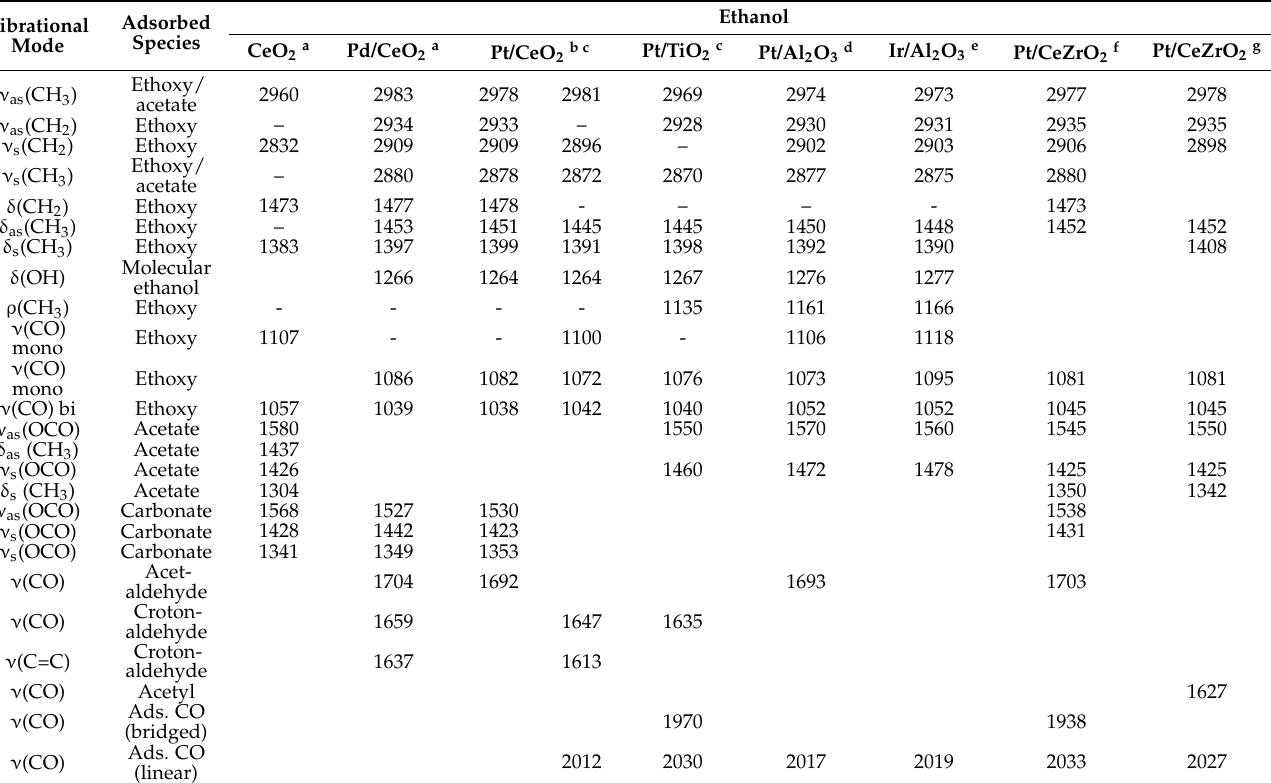
Table 2. IR vibrational wavenumbers in cm − 1 and mode assignments for the adsorption of ethanol on different catalysts from